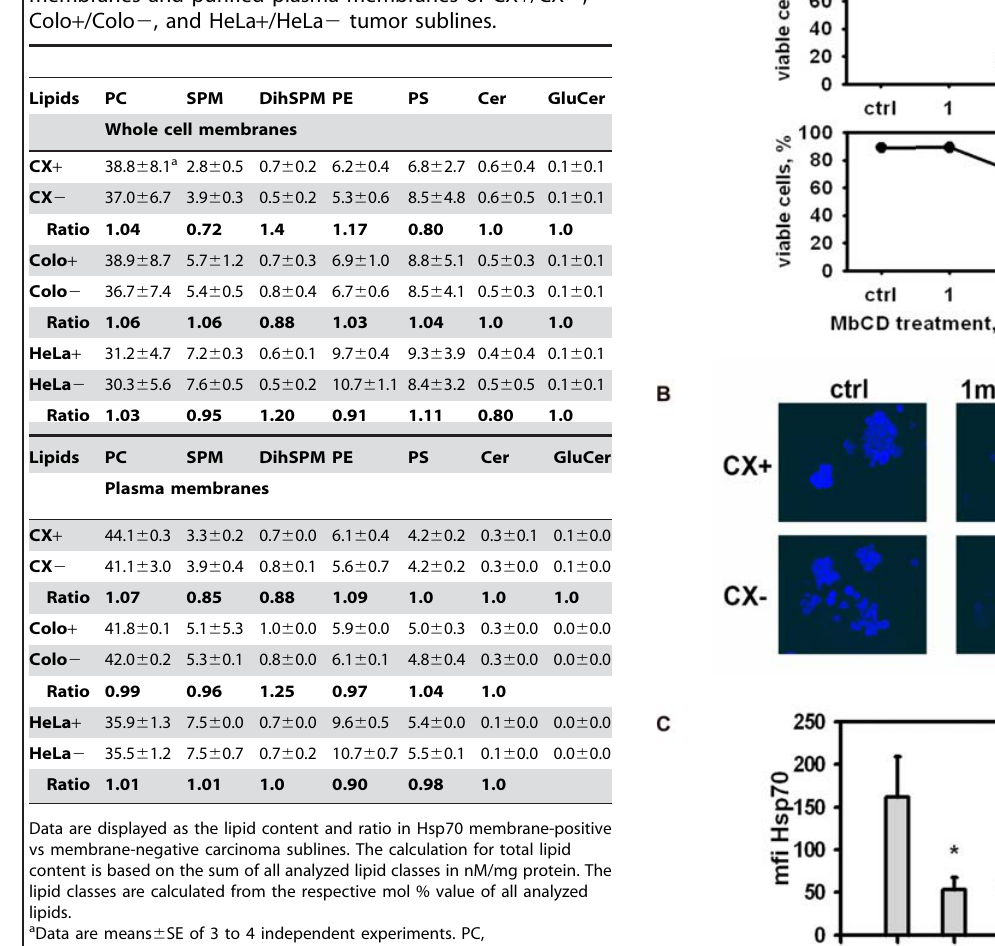
respectively. In contrast, less than 3% of total Hsp70 was found in the plasma membranes of Hsp70 low-expressing CX 2 and Colo 2 tumor sublines.